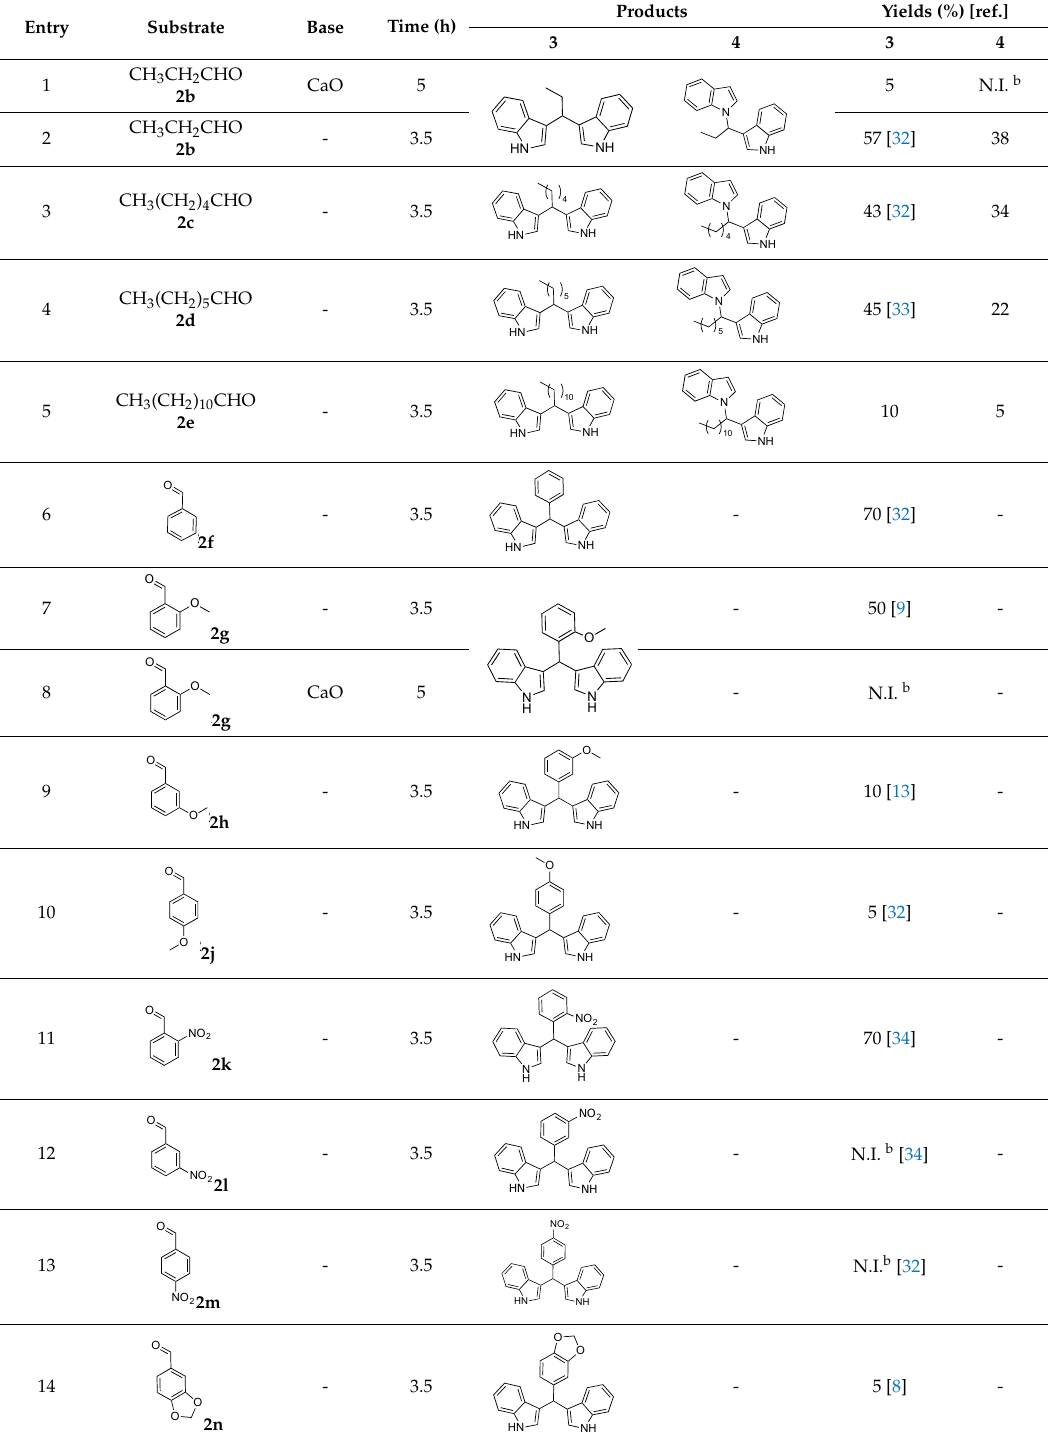
Table 2. Reaction of indole 1 with aliphatic and aromatic aldehydes. a